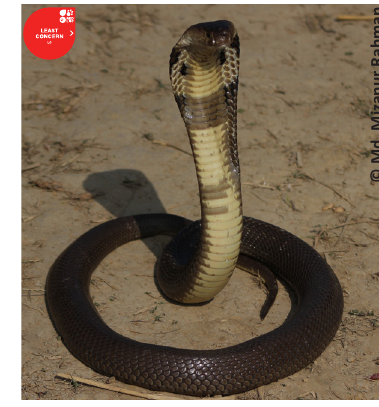
Image 13. Amphiesma stolatum Striped Keelback